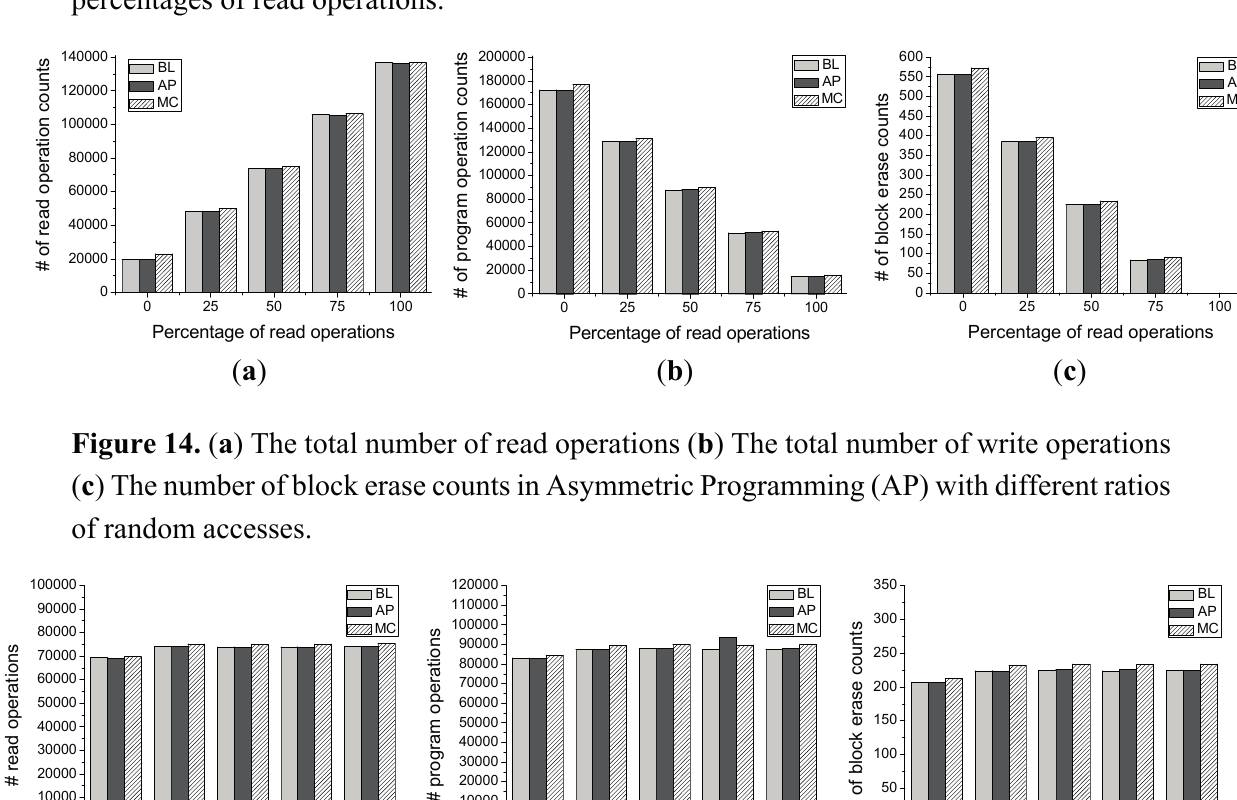
Figure 13. ( a ) The total number of read operations ( b ) The total number of write operations ( c ) The number of block erase counts in Asymmetric Programming (AP) with different percentages of read operations.